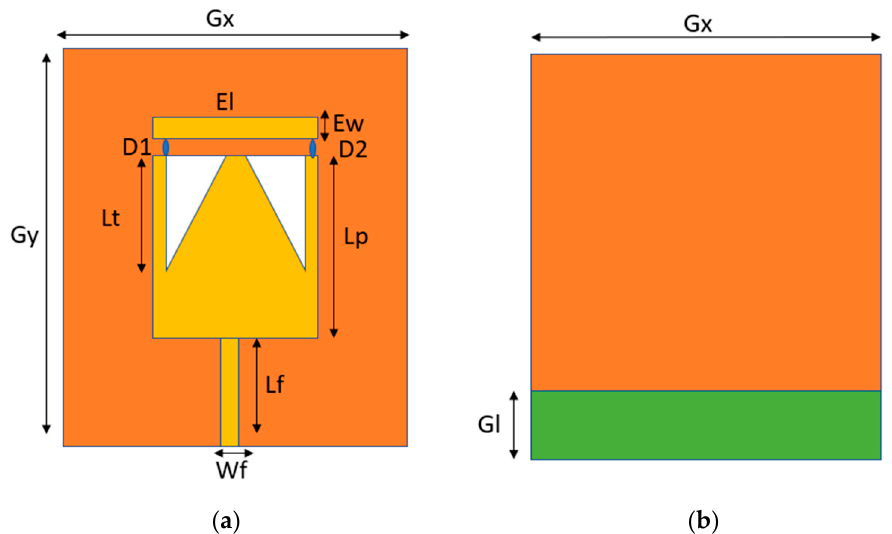
Figure 5. Design of frequency-reconfigurable rectangular patch antenna with two V-shaped extrudes using DGS: ( a ) with p-i-n diodes as a switch; ( b ) bo tt om view .